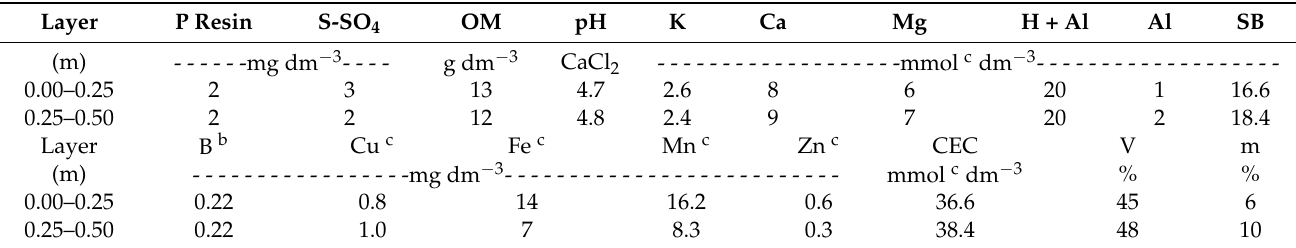
Figure 1. Monthly average rainfall and maximum, average, and minimum temperature recorded during the period of experiment. Table 1. Initial soil chemical characterization a of the experimental area in the 0.00–0.25 and 0.25–0.50 m layers.